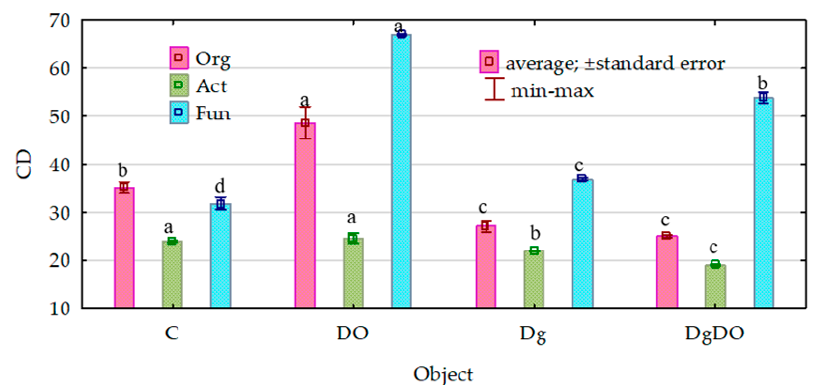
Figure 3. Effect of diesel oil (DO) and Dactylis glomerata (Dg) on the colony development index (CD). Homogeneous groups denoted with letters (a–d) were calculated separately for each of the microorganisms. C—non-polluted and non-sown soil, Dg—non-polluted soil sown with Dactylis glomerata , DO—non-sown soil polluted with diesel oil, DgDO—soil polluted with diesel oil and sown with Dactylis